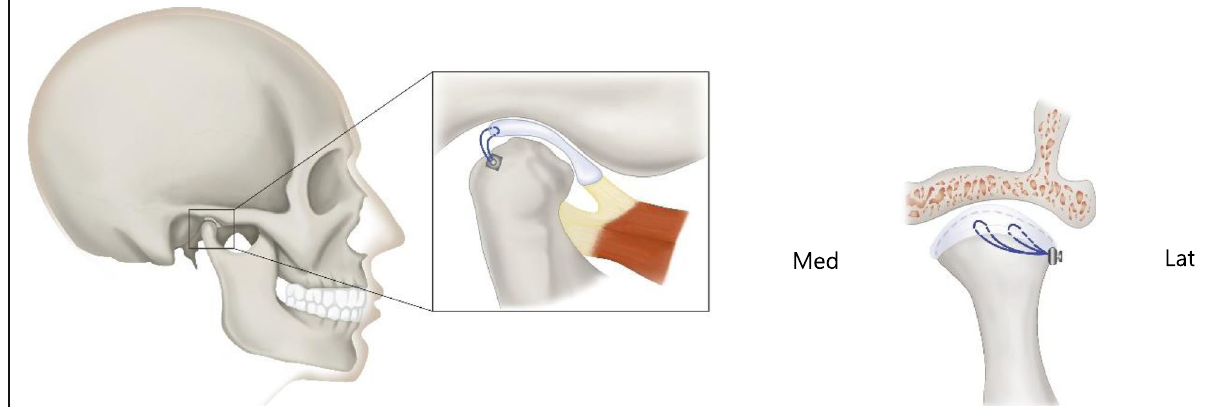
Fig. 1 Schema of position of MITEK mini anchor ( a ) and placement of two No. 2-0 polyester sutures at posterior segment of TMJ disc sutured to mini anchor placed on most lateral superior and posterior aspect of mandibular condyle ( b ). Med, medial aspect of mandibular condyle; Lat, lateral aspect of